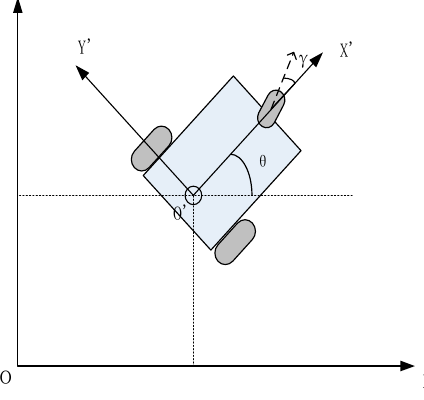
Figure 6. Kinematic model of the mobile robot.